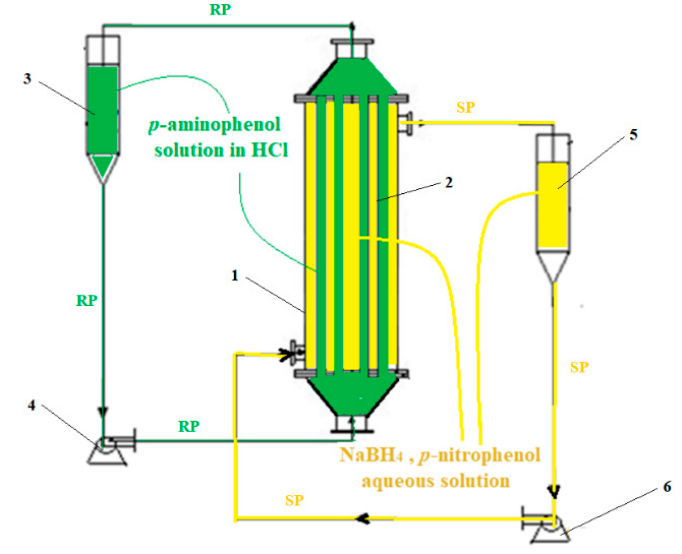
Figure 3. The schematic presentation of the installation: 1 —membrane contactor module; 2 —composite nanoparticles–polymer membranes (Os np –PM); 3 —receiving phase (HCl solution); 4 —receiving phase pump; 5 —source phase (aqueous NaBH 4 – p –nitrophenol solution); 6 —source phase. The conversion efficiency ( η %) of p –nitrophenol to p –aminophenol is calculated ei-